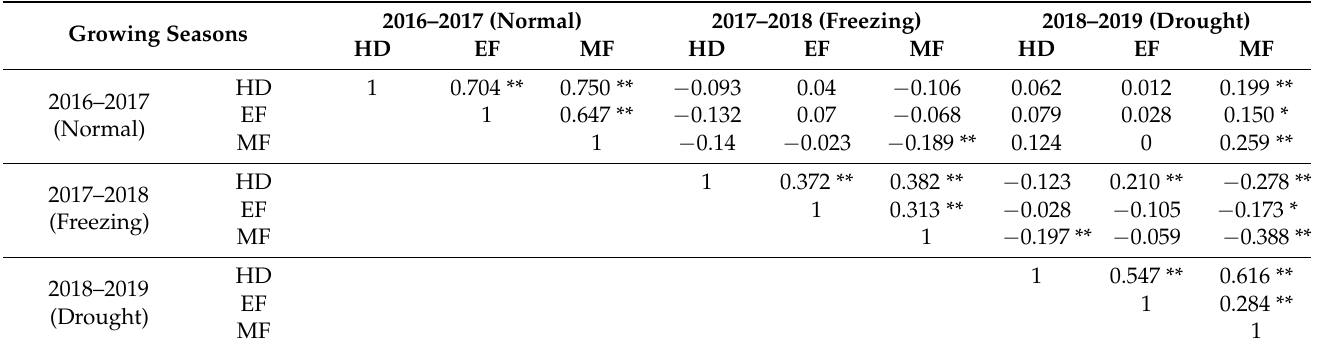
Figure 1. The average and minimum air temperature ( A ) and rainfall ( B ) during the three wheat growing seasons. A lower temperature of −0.5 °C occurred on the night of 7 April 2018, which caused serious spring freezing damage to the wheat varieties at the booting stage. The rainfall amount in the early stage (October to March) of the 2018–2019 growing season was only 55.9 mm, while it was 184.2 mm and 201.5 mm for the 2016–2017 and 2017–2018 growing seasons, respectively. Table 1. Correlation coefficients of CTDs between the three growth stages of the three growing